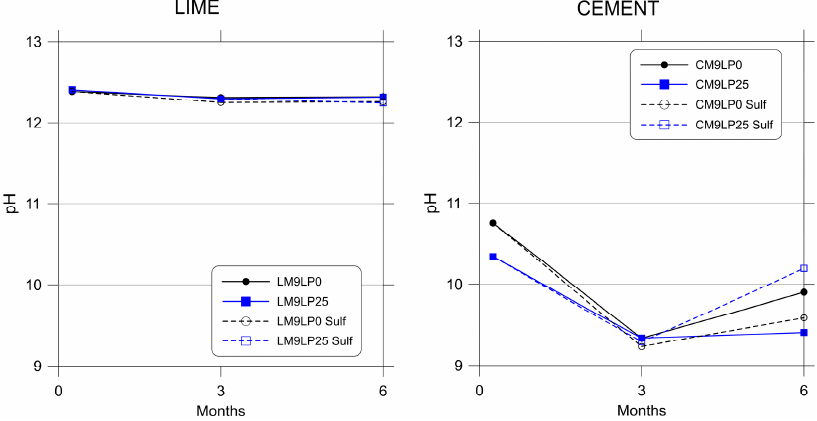
Figure 3. pH for lime and cement samples with and without the industrial waste at 7 days and at 3 and 6 months.